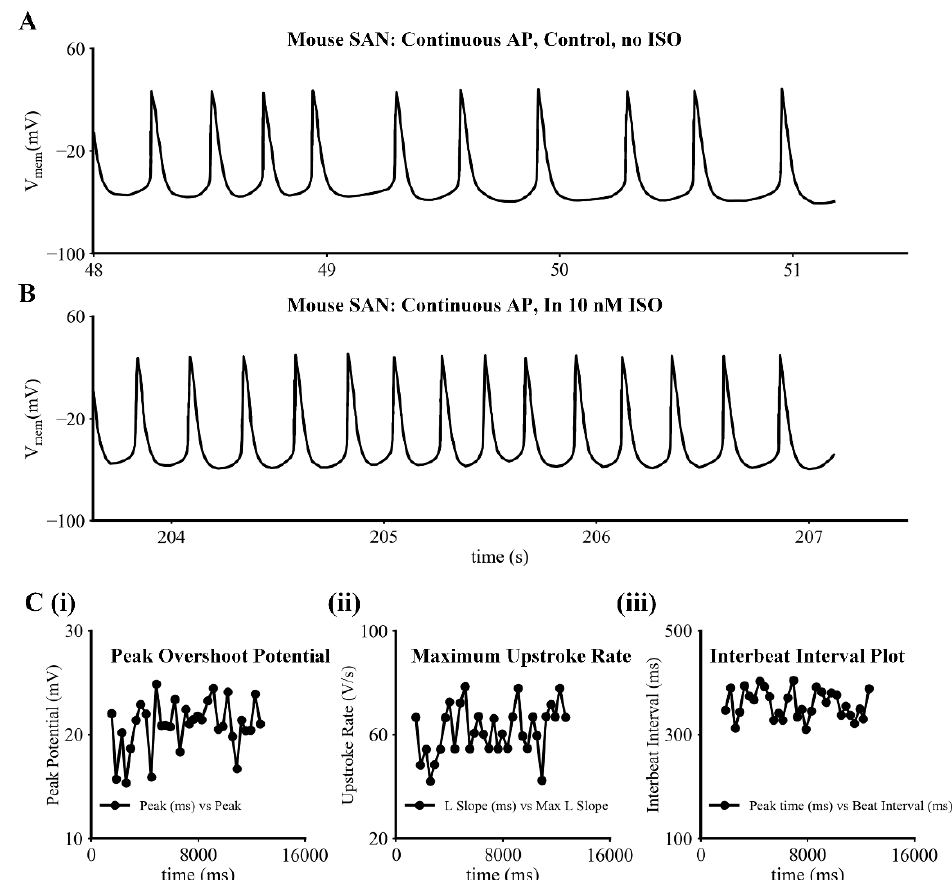
Figure 1. Intracellular recordings of spontaneous pacemaker activity from an adult mouse SAN myocyte under control conditions and in 10 nM Isoproterenol (ISO) at 35 ◦ C. ( A ) Recording of action potentials from primary pacemaker cells under control or baseline conditions. ( B ) Recording of action potentials from the same myocyte as in ( A ) 4 to 5 min after 10 nM ISO was added to the superfusate. ( C ) Numerical values for key parameters (overshoot ( i ), dV/dt ( ii ), interbeat interval ( iii )) of action potentials provide an indication of the experimental variability in these amphotericin-mediated patch electrode recordings in this study. The measured mean value of the interbeat interval is about 359.3 ms (167 beats/min) with SD = 27.3 ms and SE = 4.9 ms ( n = 33).